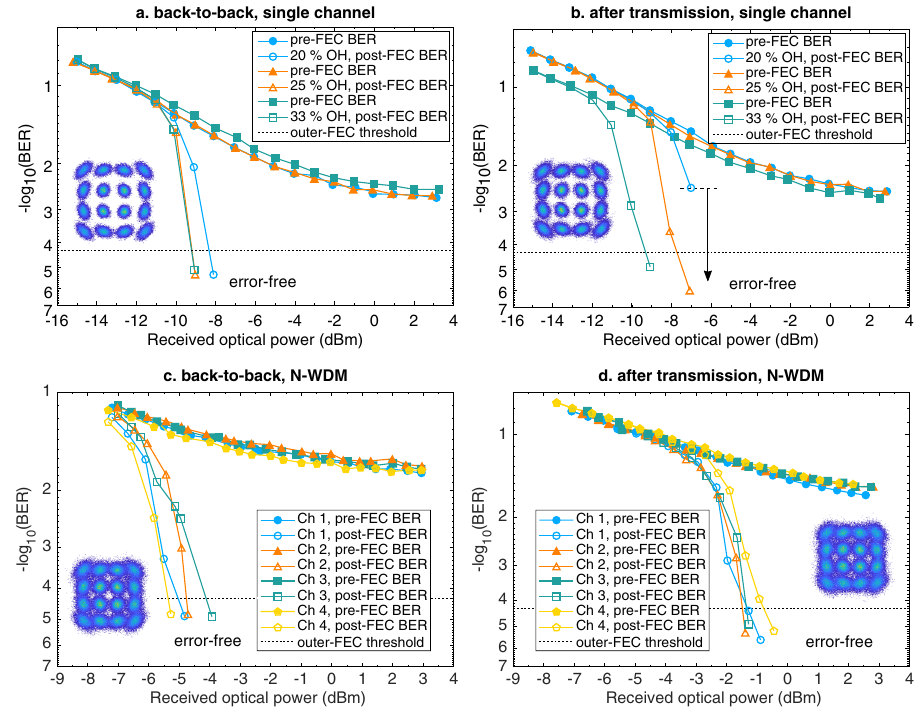
Fig. 4 Bit error ratio (BER) measurement for the 2- μ m-band signals using the 2- μ m-band transmitter and receiver based on the spectral translators. a BER performance of the single-channel 2- μ m-band 16-QAM signal at back-to-back. b BER performance of the single-channel 2- μ m-band 16-QAM signal after 1.15-km HCF transmission. Error-free performance is achieved for both back-to-back and transmission scenarios with 20%, 25% and 33% LDPC overheads, indicating a good performance margin. c BER performance of the 2- μ m-band 4 × 32 Gbaud Nyquist wavelength-division multiplexing (N-WDM) 16-QAM signal at back-to-back. d BER performance of the 2- μ m-band 4 × 32 Gbaud N-WDM 16-QAM signal after 1.15-km HCF transmission. With 33% LDPC overhead, error-free performance is achieved for both back-to-back and transmission scenarios. Insets give the typical constellation diagrams of the 16-QAM signals that can achieve error-free performance after forward error correction (FEC) top. The aluminium composition (x) for Al x Ga 1 − x As is 21%. The AlGaAsOI wafer was achieved by wafer bonding and substrate removal 42 . Then, the nanowaveguides and tapers were de fi ned by E-beam lithography followed by a boron trichloride- based dry etching process. Both the E-beam process and the dry etching process were optimized to ensure minimal sidewall roughness 31 . The oxide-like E-beam resist hydrogen silsesquioxane was left on top of the nanowaveguide for the simplicity of fabrication. Another 3- μ m-thick silicon dioxide layer was lastly deposited on top of the nanowaveguides by plasma-enhanced chemical vapour deposition to form a cladding. The sample was lastly cleaved at the inverse tapers, which were probed by lensed fi bres for light coupling. The 1.74- μ m-band TDFA . For the 1.74- μ m pump source, we developed an all- fi bre short-wavelength (1650 – 1800nm) TDFA using commercially available thulium-doped fi bre (TDF) (OFS TmDF200). To enhance the short-wavelength gain of the TDFA a relatively short overall length of TDF (~1.2 m) was used to reduce the signal reabsorption and an additional short-pass spectral fi lter was incorporated within the ampli fi er to suppress gain and the build-up of ampli fi ed spontaneous emission/spurious lasing at longer wavelengths. The short-pass fi lter was based on macrobend-induced loss from a 10m length of dispersion com- pensating fi bre (DCF) (Thorlabs DCF38), wound on a mandrel at an optimized bend diameter of 5.5cm. This fi lter was spliced into the middle of the active fi bre to increase the available gain at the 1.74- μ m band 36 . The fi bre was core pumped in a bidirectional con fi guration by an in-house built erbium-doped fi bre laser operating at 1560 nm. The ampli fi er provides a maximum small-signal gain of >30dB at 1750 nm and supports gain over a more than 200 nm wide spectral window in the range 1730 – 1950 nm. In our experiment, the ampli fi er was seeded by a discrete mode DFB laser diode operating at 1739.74 nm (Eblana Photonics EP1742-DM-B) and the maximum achievable output power was higher than 500mW with an optical signal-to-noise ratio (OSNR) of >40dB (as shown in Fig. 3). The 1.15-km HCF . The HCF used in our experiment is a hollow-core photonic bandgap fi bre with a 19-cell core structure designed to operate in the 2 μ m region and was previously fabricated in-house using a conventional stack and draw technique 20 . The central hollow core region is surrounded by multiple periodic -ring layers of air holes and glass struts (i.e. micro-structured cladding with a 7 1 2 structure) and most of the light (>99%) propagates in air rather than silica glass